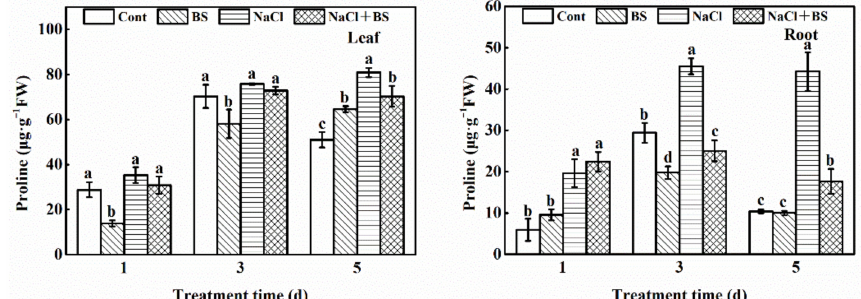
Figure 8. Effect of B. cereus on the content of proline in cucumber seedlings under salt stress. Bars represent standard errors. Different letters indicate a significant difference in the same parameter between treatments at p <